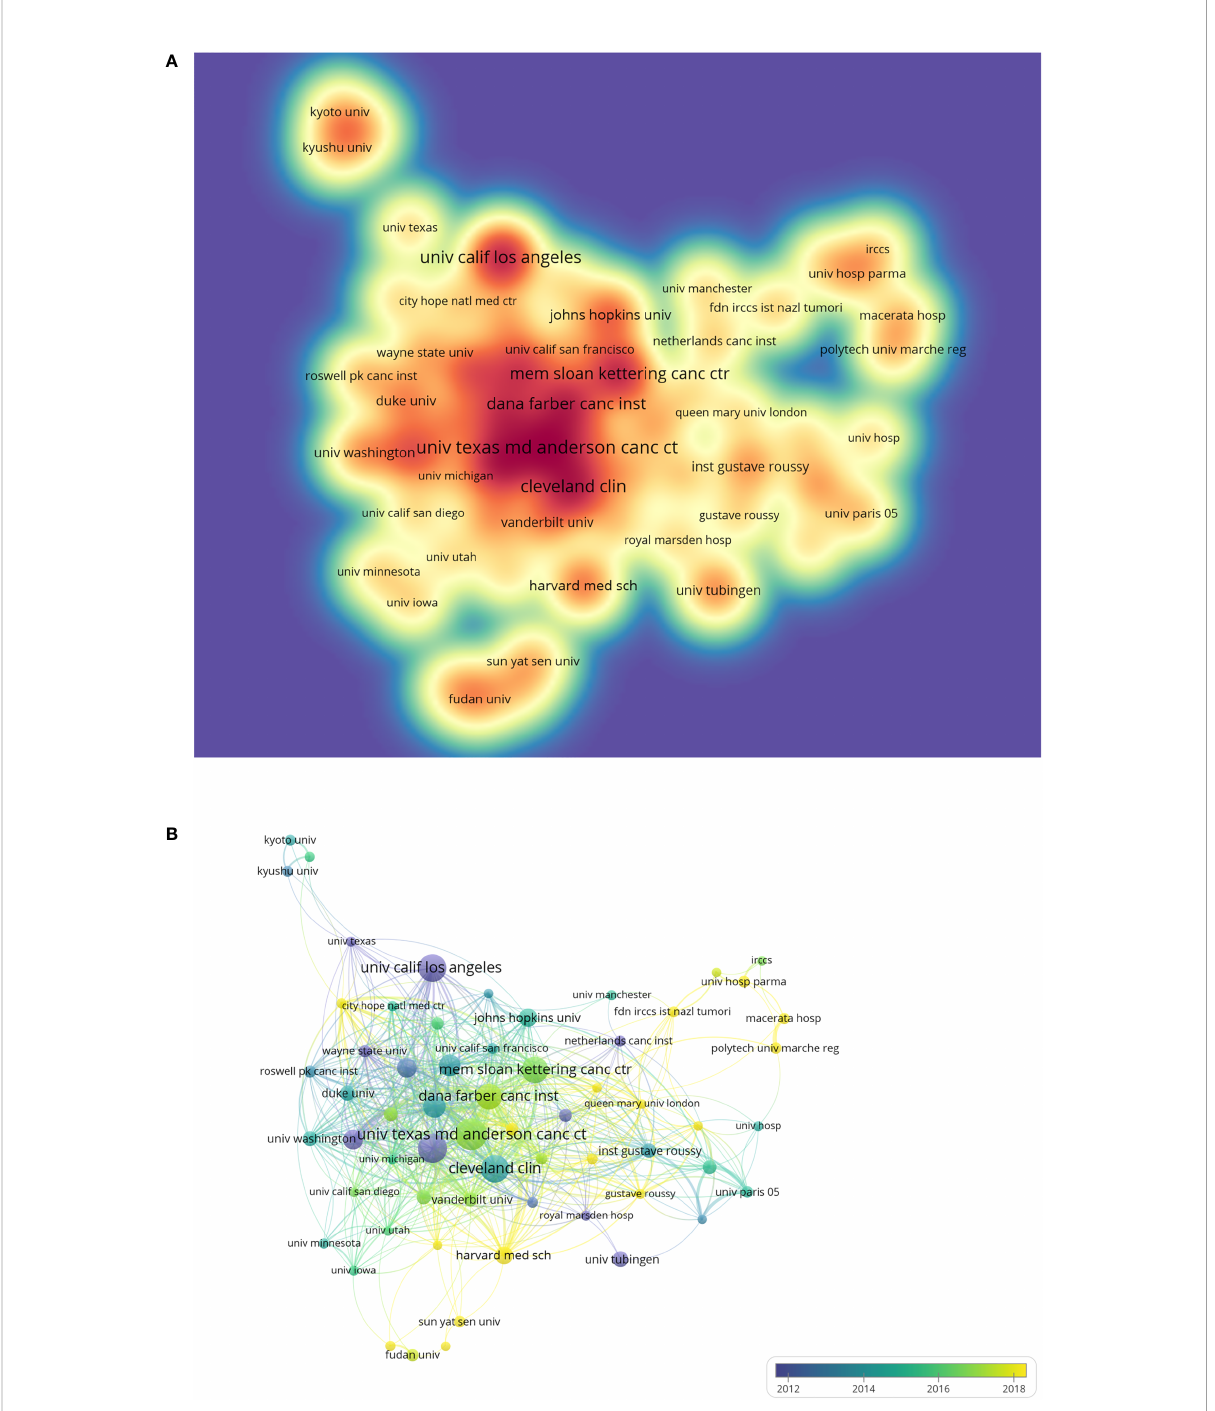
FIGURE 4 (A) The spectral density map of organizations was performed with VOSviewer. The deeper the color of the node, the more documents the organization published. (B) The overlay visualization map of organizations ’ collaborations based on VOSviewer. The purple nodes represented the early institutions that participated in the research in this fi eld, while the yellow nodes re fl ected the later